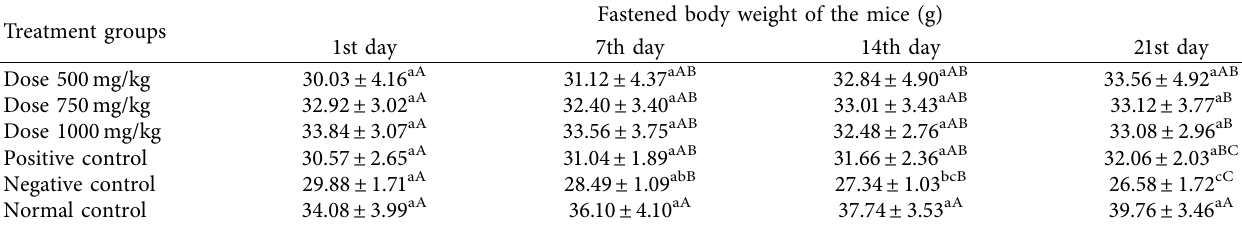
Table 1: Effects of the microencapsulated bioactive product of M. stenopetala on the body weight of the mice. Treatment groups